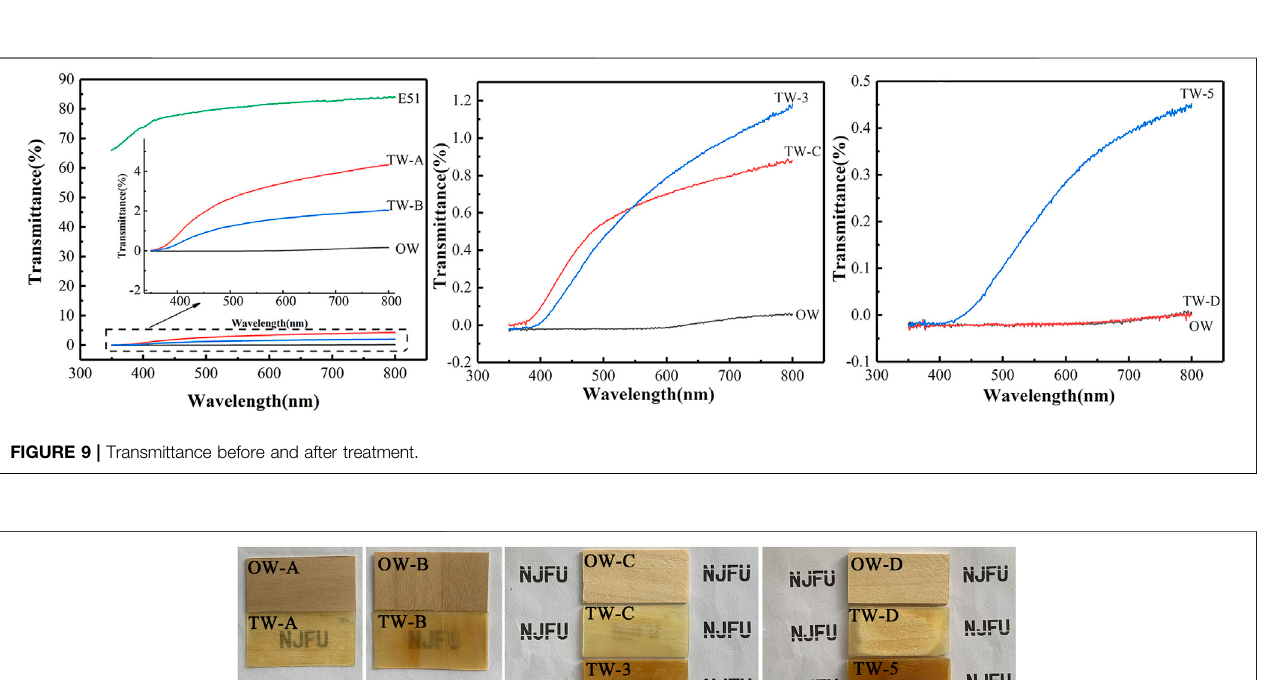
*The relative thicknesses of different layers are all 0.5 mm The values in brackets are the values of standard deviation.